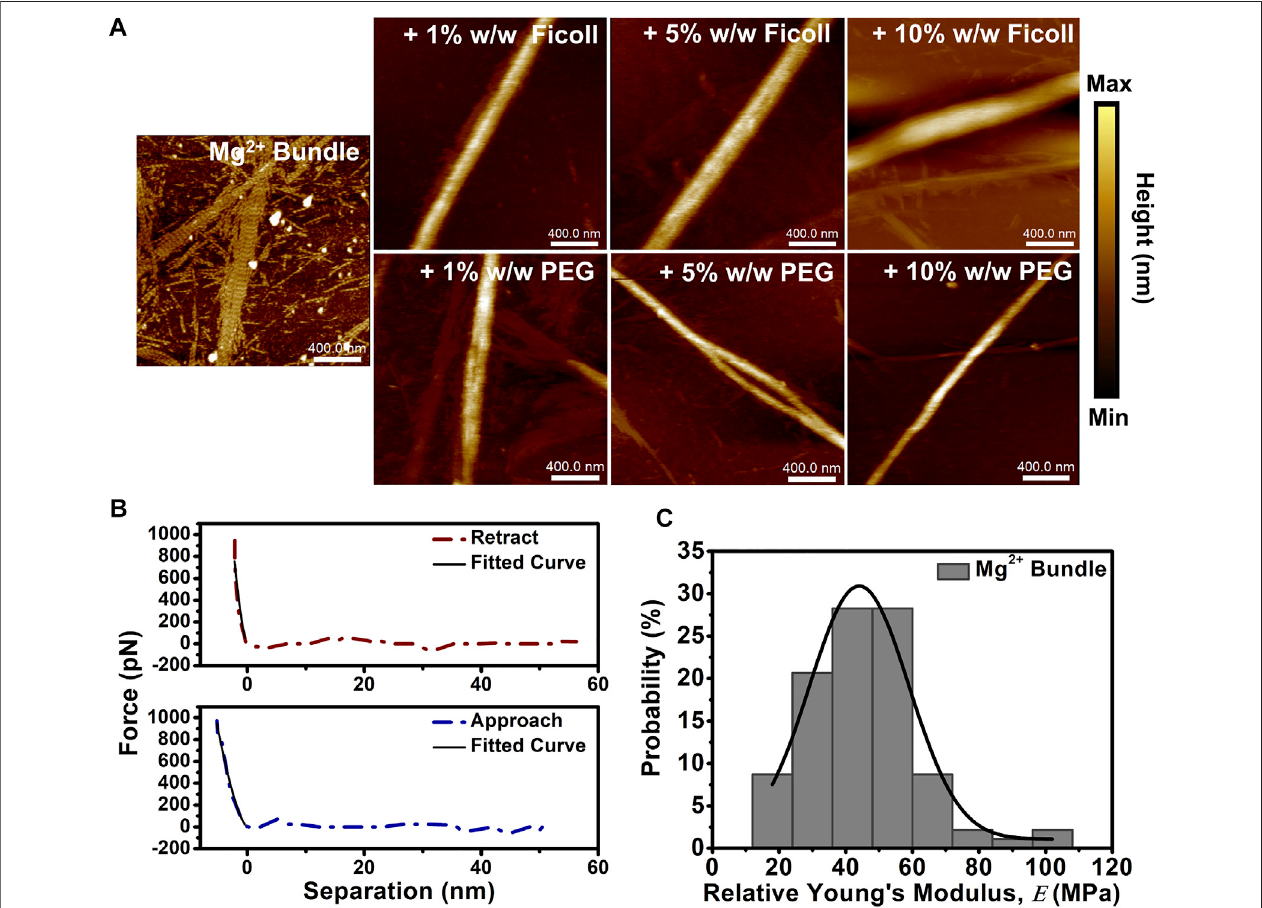
FIGURE 1 | Cation-induced bundle atomic force microscopy (AFM) imaging and nanomechanical analysis in macromolecular crowded environments. (A) Representative AFM images of cation-induced bundles in the absence and presence of increasing concentrations of Ficoll (1 – 10% w/w) or PEG (1 – 10% w/w). Actin bundle ≈ 15 µM and scale bar (cid:2) 400 nm. (B) Representative cation-induced actin bundle retract and approach force curves demonstrating the elastic behavior of the bundle; solid lines indicate fi t using Hertz model. (C) Histogram of Mg 2+ -induced bundle control E obtained from force curve measurements along the bundle. The distribution of E is fi t with Gaussian function (solid line). Total number of force curves analyzed N ≈ 150.